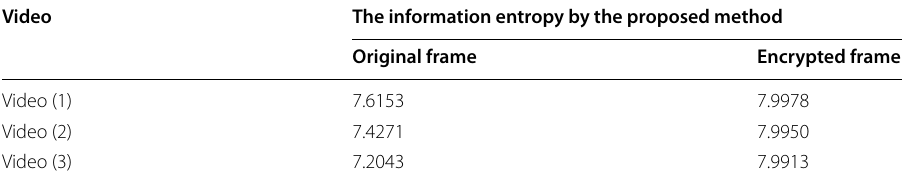
Table 1 The information entropy by the proposed method in different videos Video